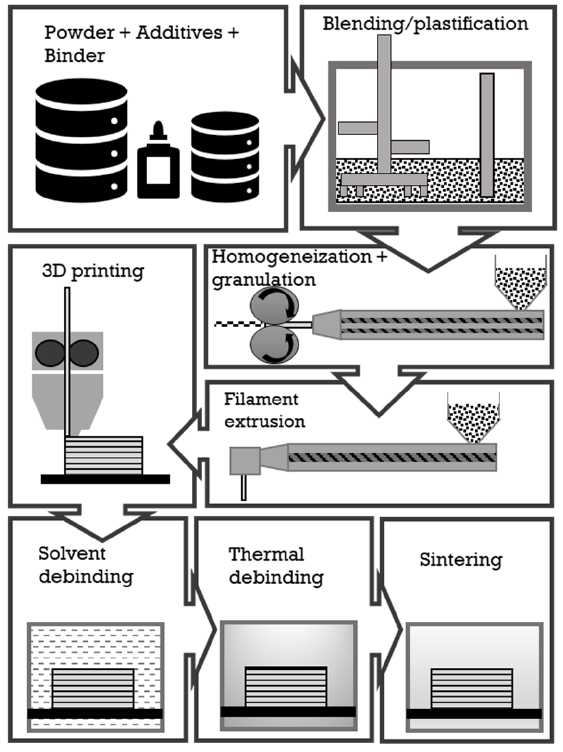
Figure 1. Schematic representation of the process. After the granulation, all the feedstocks were dried in an oven at 40 ◦ C for 48 h. The feedstock was then homogenized three times through a twin-screw extruder (HAAKE Polylab OS Rheomex PTW16/25 OS, Thermo Fisher Scientific, Karlsruhe, Ger- many) with the temperature settings for the segments ranging from 85 °C to 135 °C. A single screw extruder (HAAKE Polylab OS Rheomex 19/10 OS, Thermo Fisher Scientific, Karlsruhe, Germany) was used to produce the 1.75 mm diameter filaments combined with an in-house filament cooling and pulling machine (cf. Figure 2) with an integrated regulation system through an ODAC 14XY laser diameter sensor (Zumbach Electronic GmbH, Pulheim, Germany). The segment temperatures of the extruder were set between 100 and 130 °C.